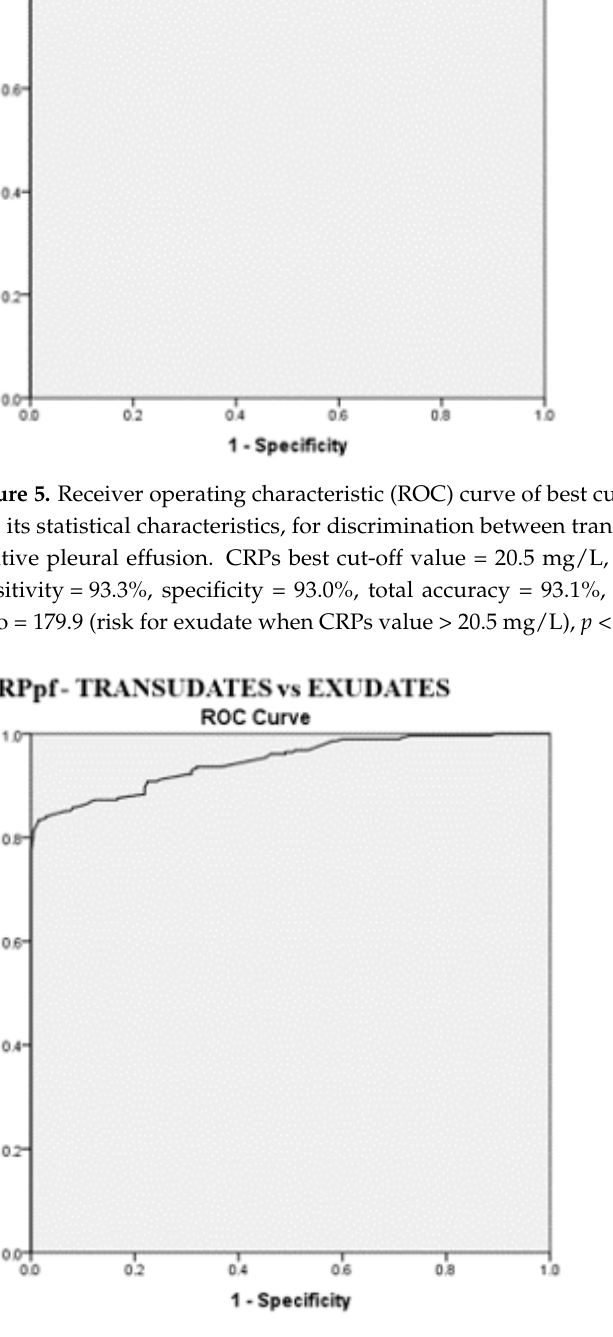
Figure 6. ROC curve of best cut-off value of pleural fluid CRP (CRPpf), and its statistical characteristics, for discrimination between transudative pleural effusion and exudative pleural effusion. CRPpf best cut-off value = 9.9 mg/L, AUC = 95% (95% CI: 92.9–96.5), sensitivity = 85.1%, specificity = 93.3%, total accuracy = 89%, PPV = 94%, NPV = 80%, odds ratio = 80 (risk for exudate when CRPpf value > 9.9 mg/L), p < 0.0001.